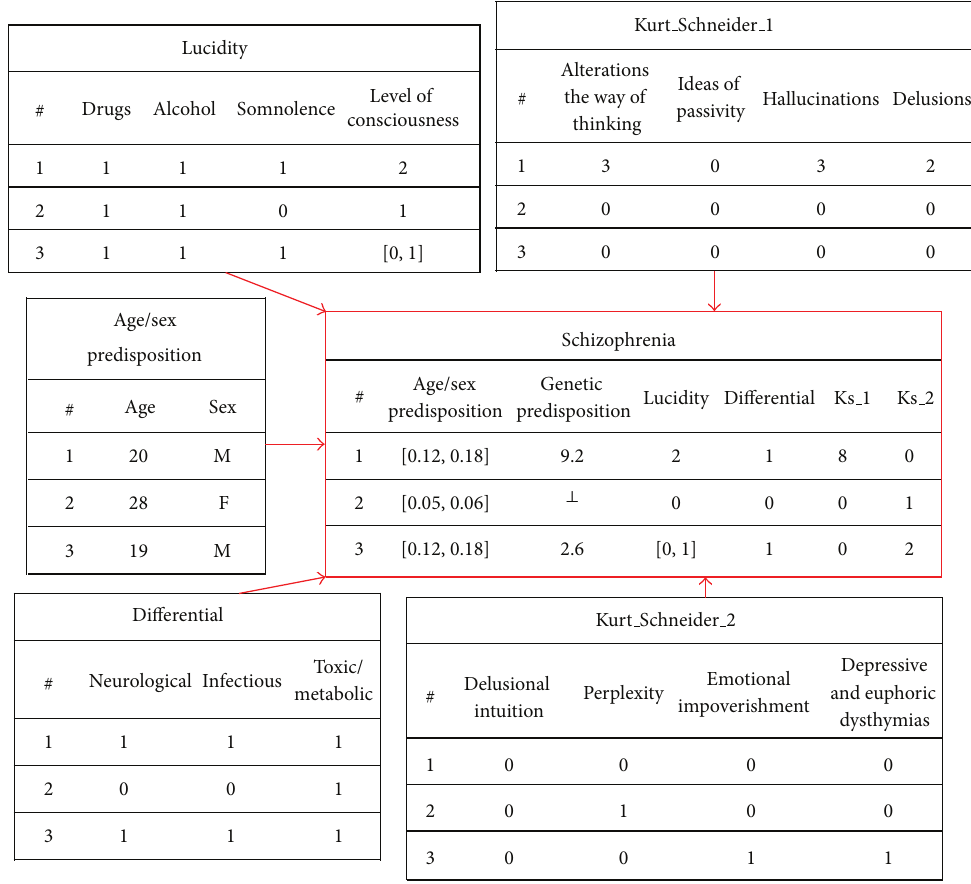
Figure 2: An extension of the relational database model.